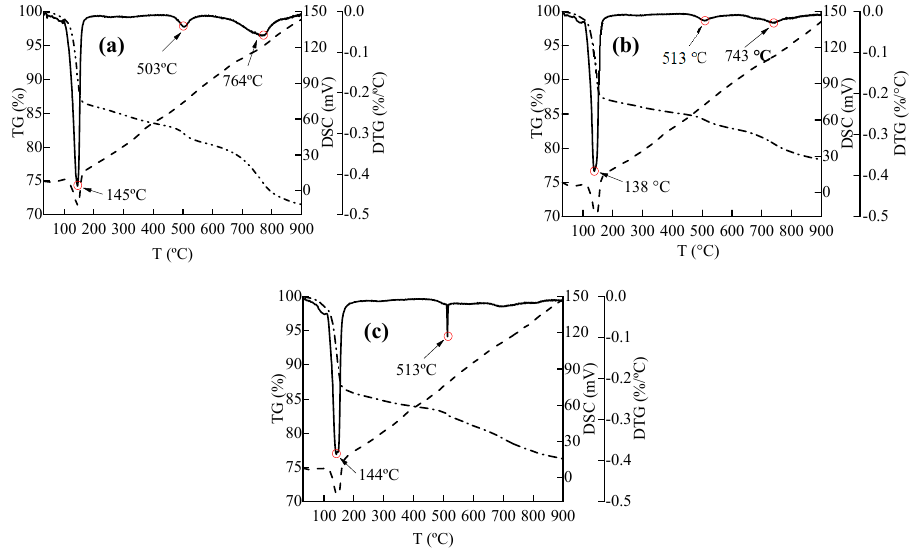
Figure 8. Thermal-analysis curves of the powdery precipitated substances at different water–cement ratios: ( a ) C20 specimen; ( b ) C30 specimen; and ( c ) C40 specimen.